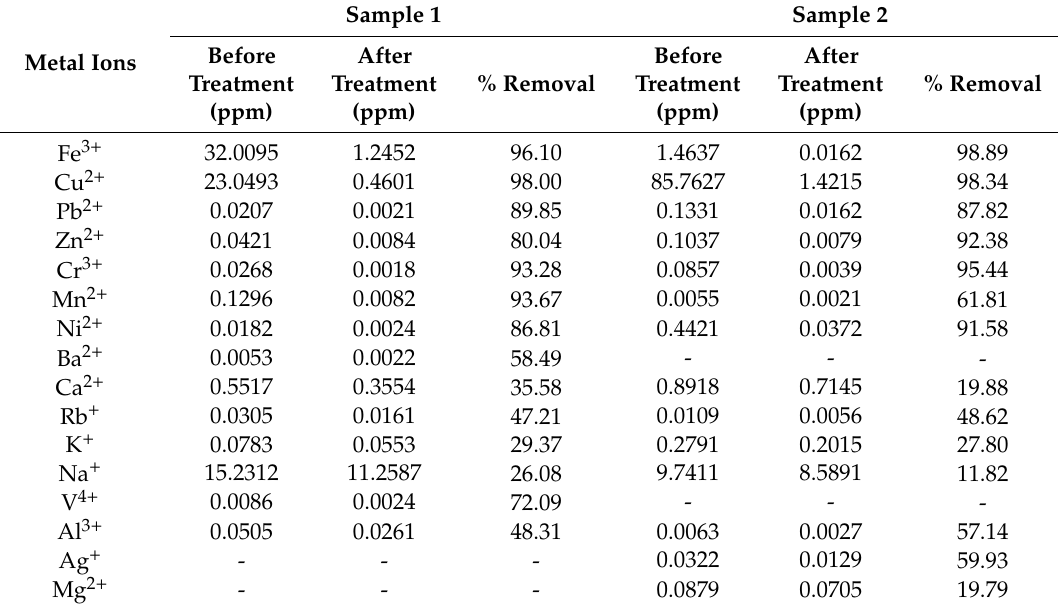
Table 6. Compositions of metal ions into industrial wastewater samples (Sample 1 and Sample 2) before and after treatment by PA